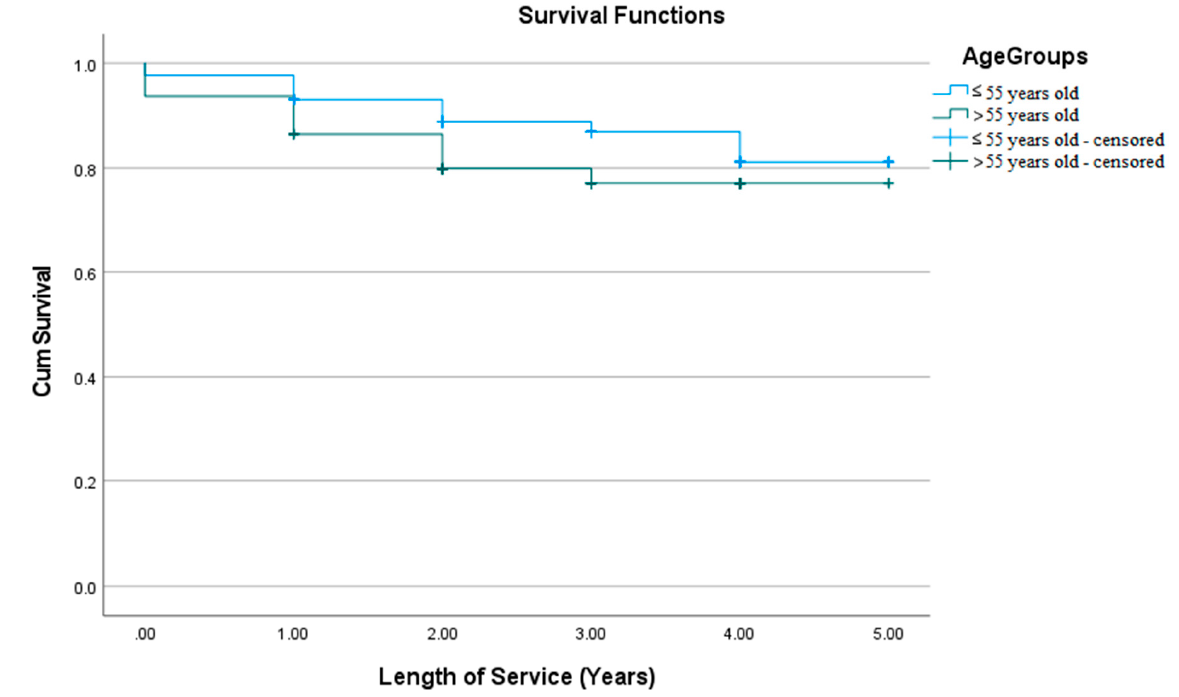
Table 5. Equality of survival distributions for the different levels of failure risk factors, Palacky University Hospital, 2014–2018 ( n = 469). Log Rank (Mantel-Cox) Chi-Squared df Sig. Age Group 4.514 1 0.034 Cement Material 10.310 1 0.001 Cement Viscosity 12.522 1 <0.001 Kaplan-Meier analysis was executed with a significance level (Sig.) of ≤ 0.05